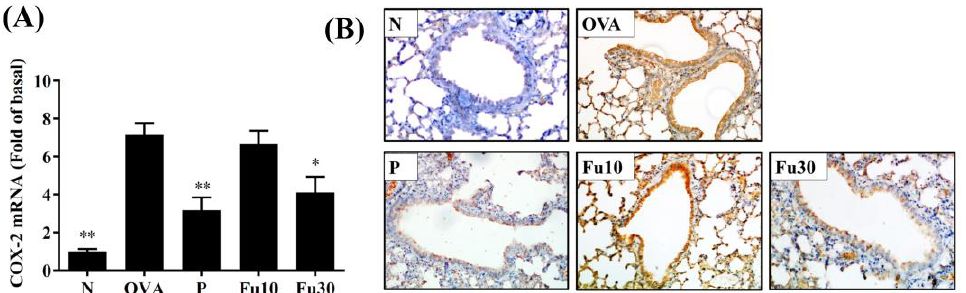
Figure 8. The effects of fucoxanthin (Fu) on COX-2 expression in the lung tissues from OVA-sensitized mice. ( A ) COX-2 gene expression was detected by real-time RT-PCR and fold-changes in expression measured relative to β -actin (internal control). ( B ) COX-2 expression was analyzed by immunohistochemistry staining and labeled as a brown colored drop. Three independent experiments were analyzed. Data are presented as mean ± SEM. * p < 0.05, ** p < 0.01 compared to the OVA control group. 10 mg/kg and 30 mg/kg fucoxanthin were named as Fu10 and Fu30, respectively. 5 mg/kg prednisolone was named as P.